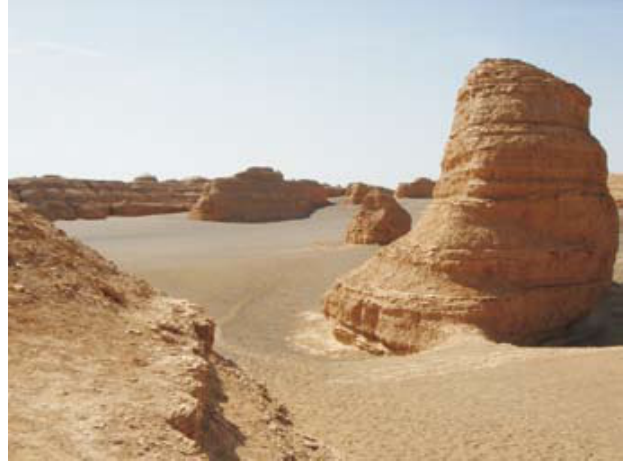
Figure 2. Wind-eroded landforms in the Yadan National Geological Park, Gansu Province, China, resulting from the dryness of a paleolake over the Pliocene-Pleistocene climate transition. Decreasing regional rainfalls are supposed to be closely tied to the Himalayan uplift associated to changes in the atmospheric pattern.